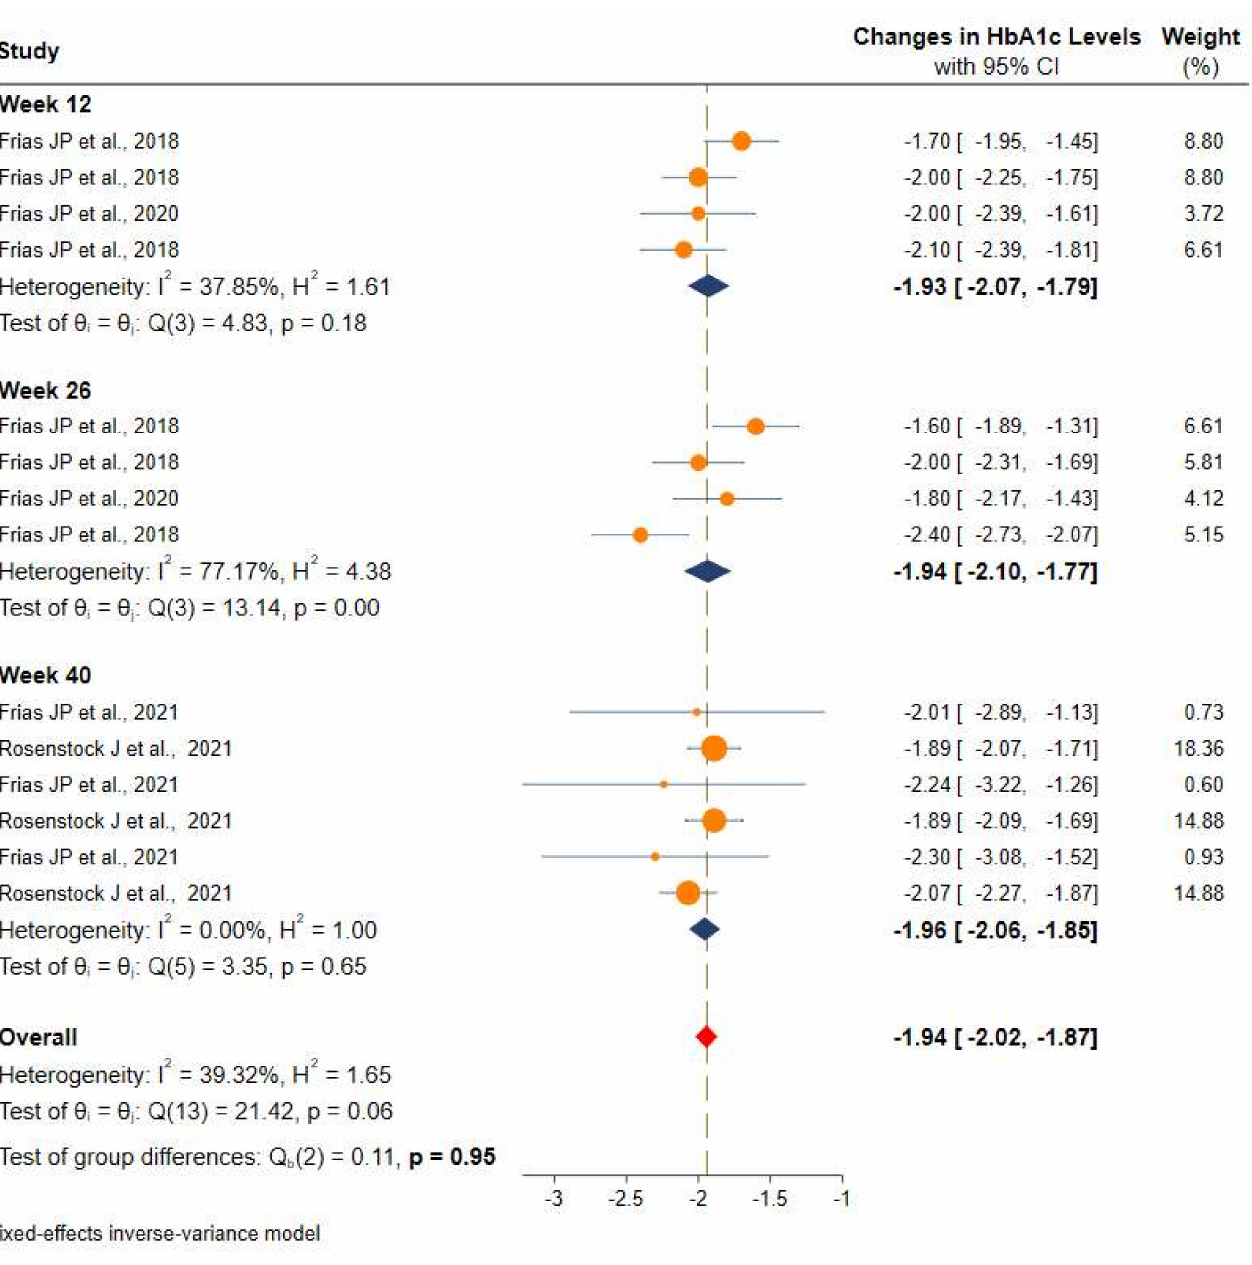
Figure 4. Efficacy of once-weekly tirzepatide on glycated hemoglobin (HbA1c) based on duration of